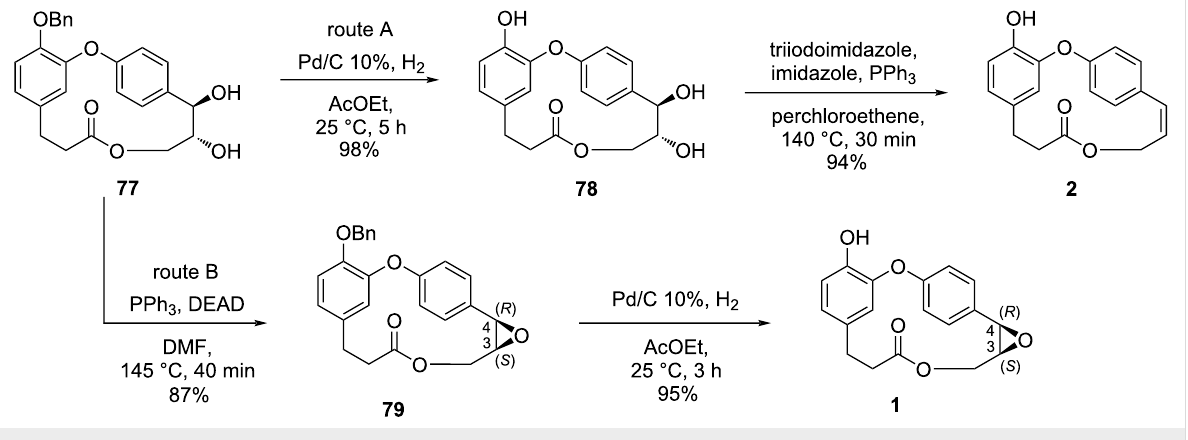
Scheme 15: Synthesis of combretastatins 1 and 2 by Couladouros and co-workers [44,45].